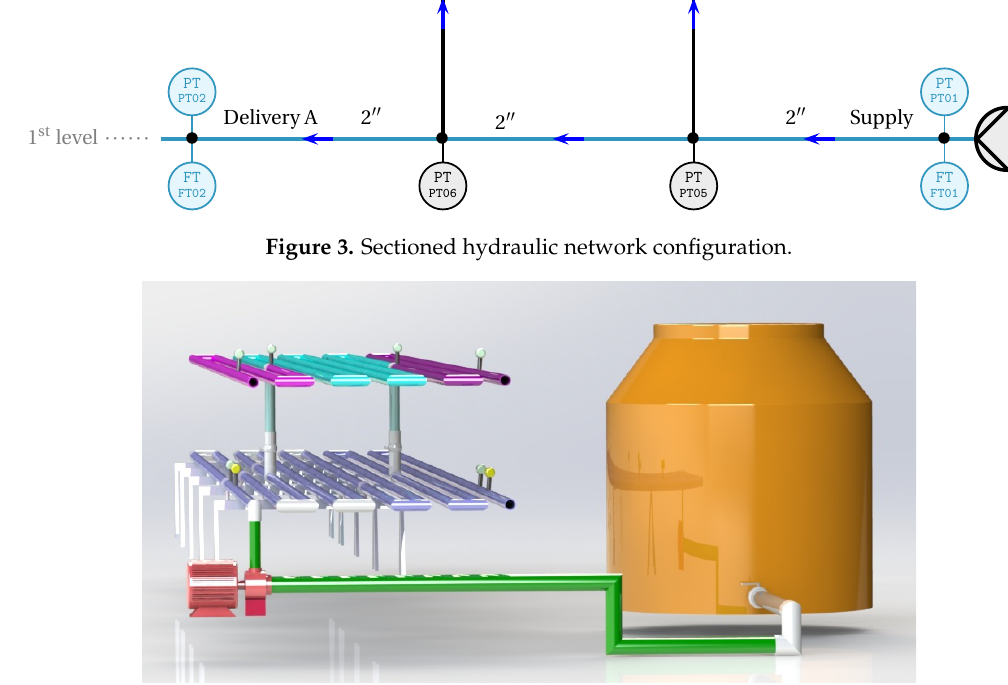
Figure 4. Front view of the hydraulic network in SolidWorks R (cid:13)